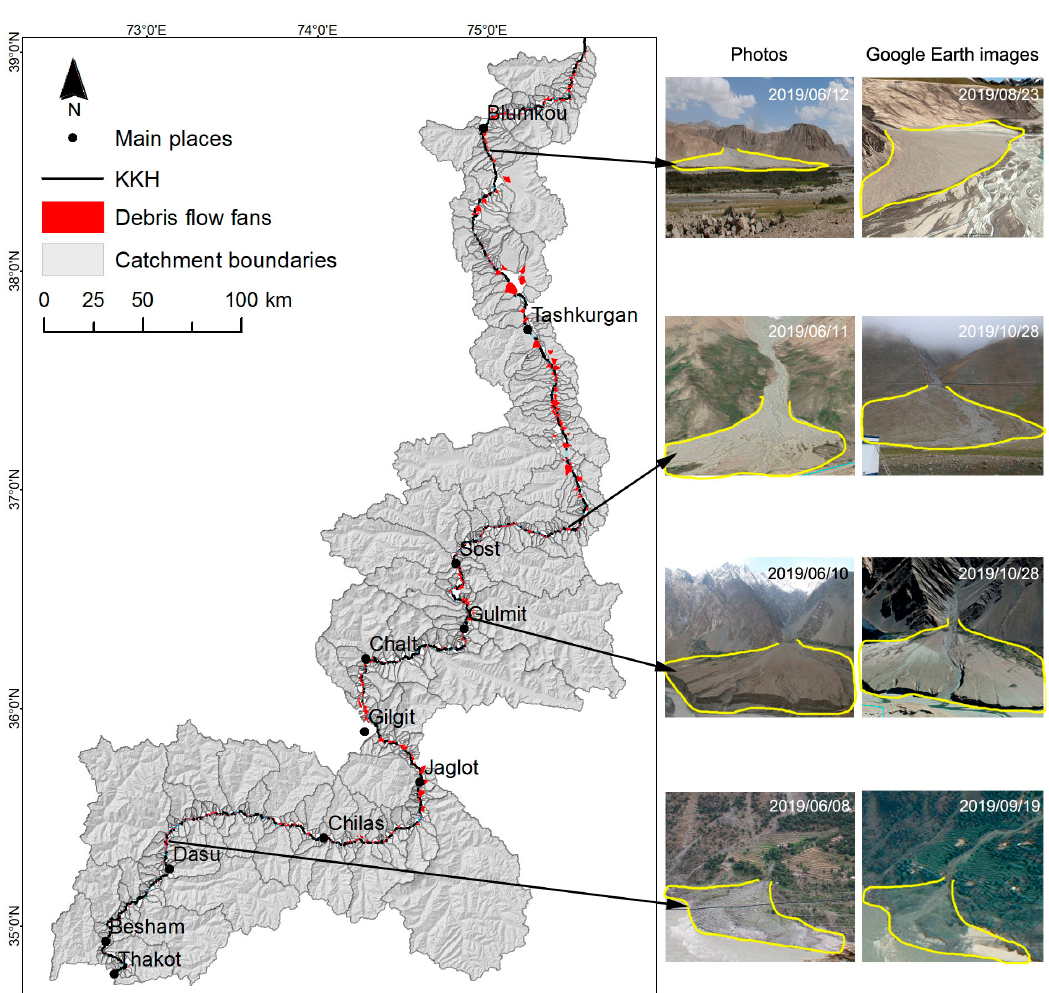
Figure 3. Results of the identification results of debris flow accumulation fans along the KKH, and comparison of Google Earth images and field photos of typical debris flow fans. (The photo was taken by Xiaojun Su from the field survey).